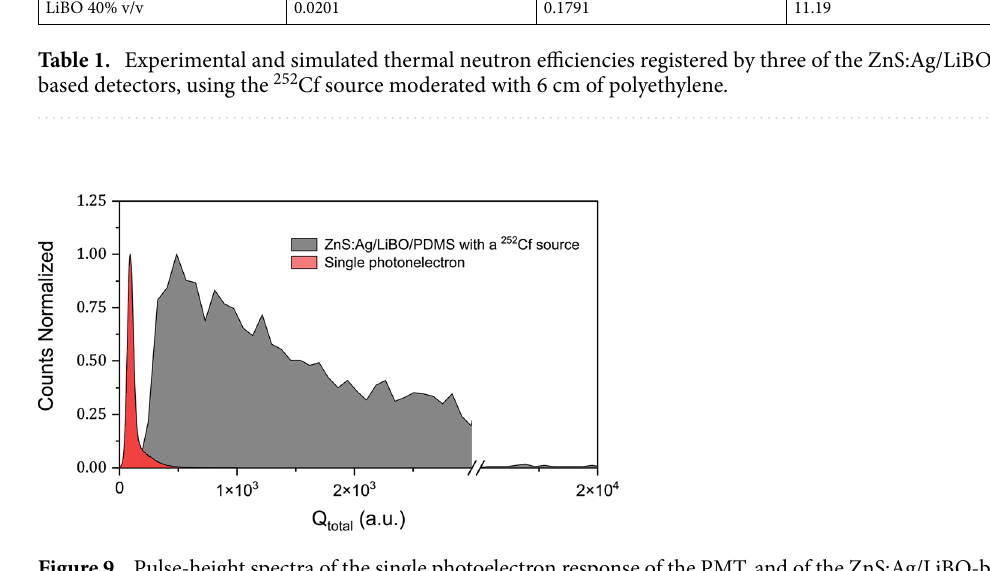
Figure 9. Pulse-height spectra of the single photoelectron response of the PMT, and of the ZnS:Ag/LiBO-based detector using a 252 Cf source moderated with 6 cm of